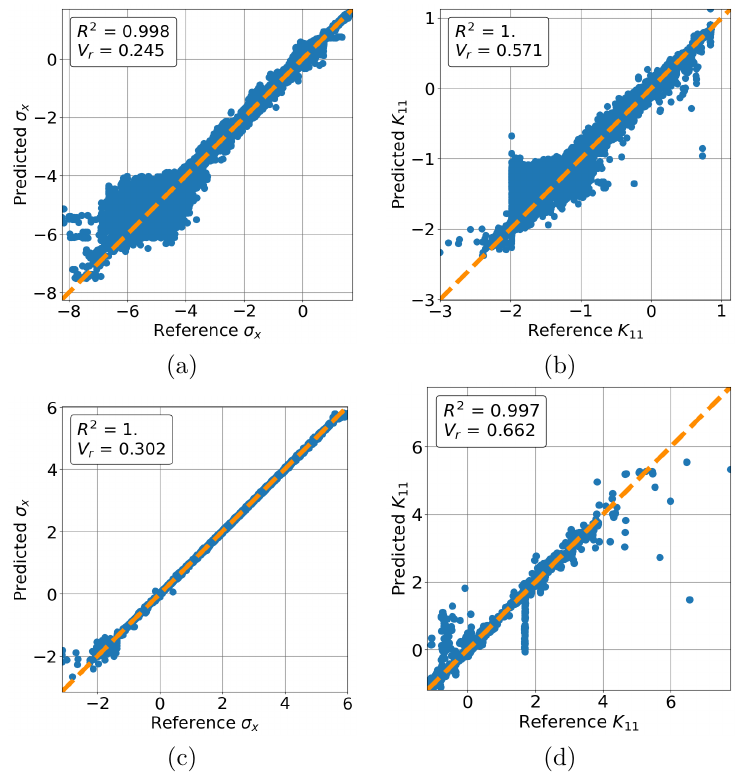
Figure 5. LGBM results for: (a) stress component σ component σ in CF 1, and (d) stiffness component K x